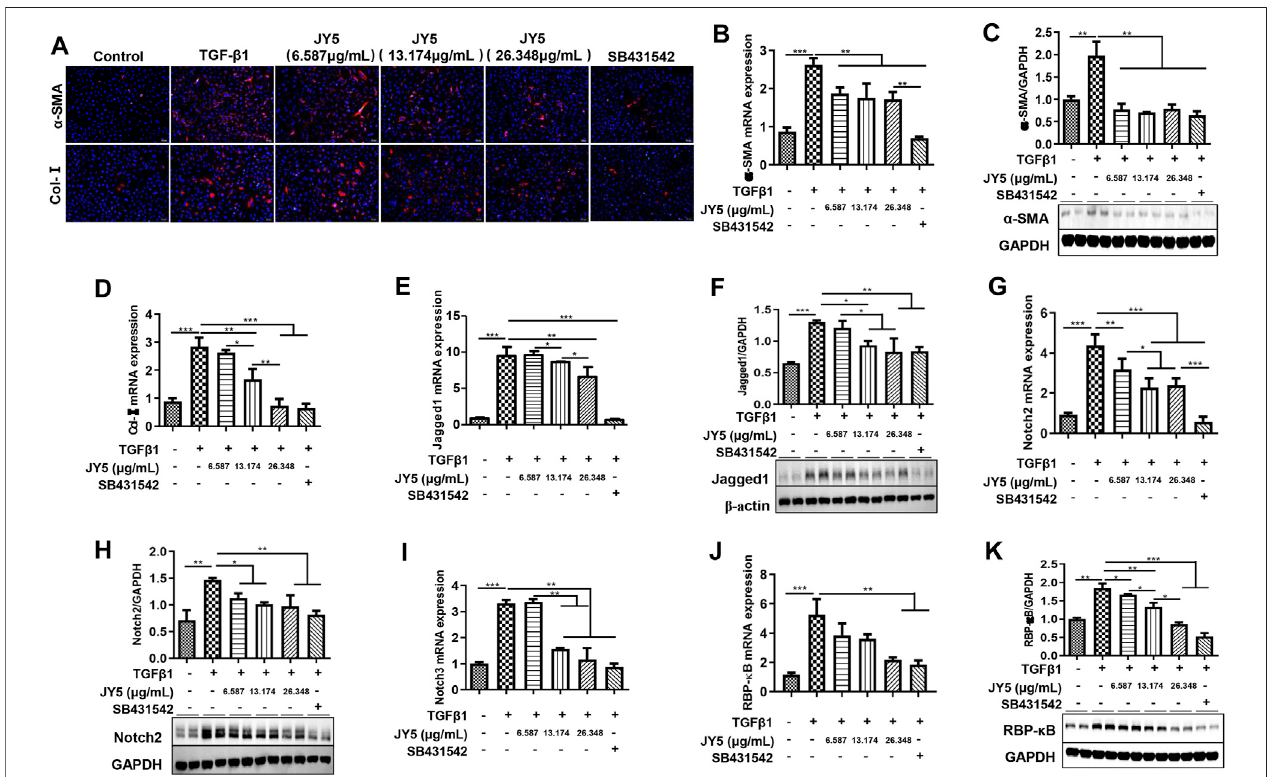
FIGURE 7 | JY5 inhibits the activation of LX-2 cells induced by TGF- β 1 by repressing the Notch signaling pathway. (A) Representative images of Immuno fl uorescence staining (100 × ) for a -SMA and Col- Ⅰ . The mRNA expressions of α -SMA (B) , Col-I (D) , Jagged1 (E) , Notch2 (G) , Notch3 (I) and RBP- κ B (J) were measured by qPCR. Western blotting and quantitative analysis of a -SMA ( C ), Jagged1 (F) , Notch2 (H) and RBP- κ B (K) protein in cell lysate. * p < 0.05, ** p < 0.01, and *** p < 0.001.